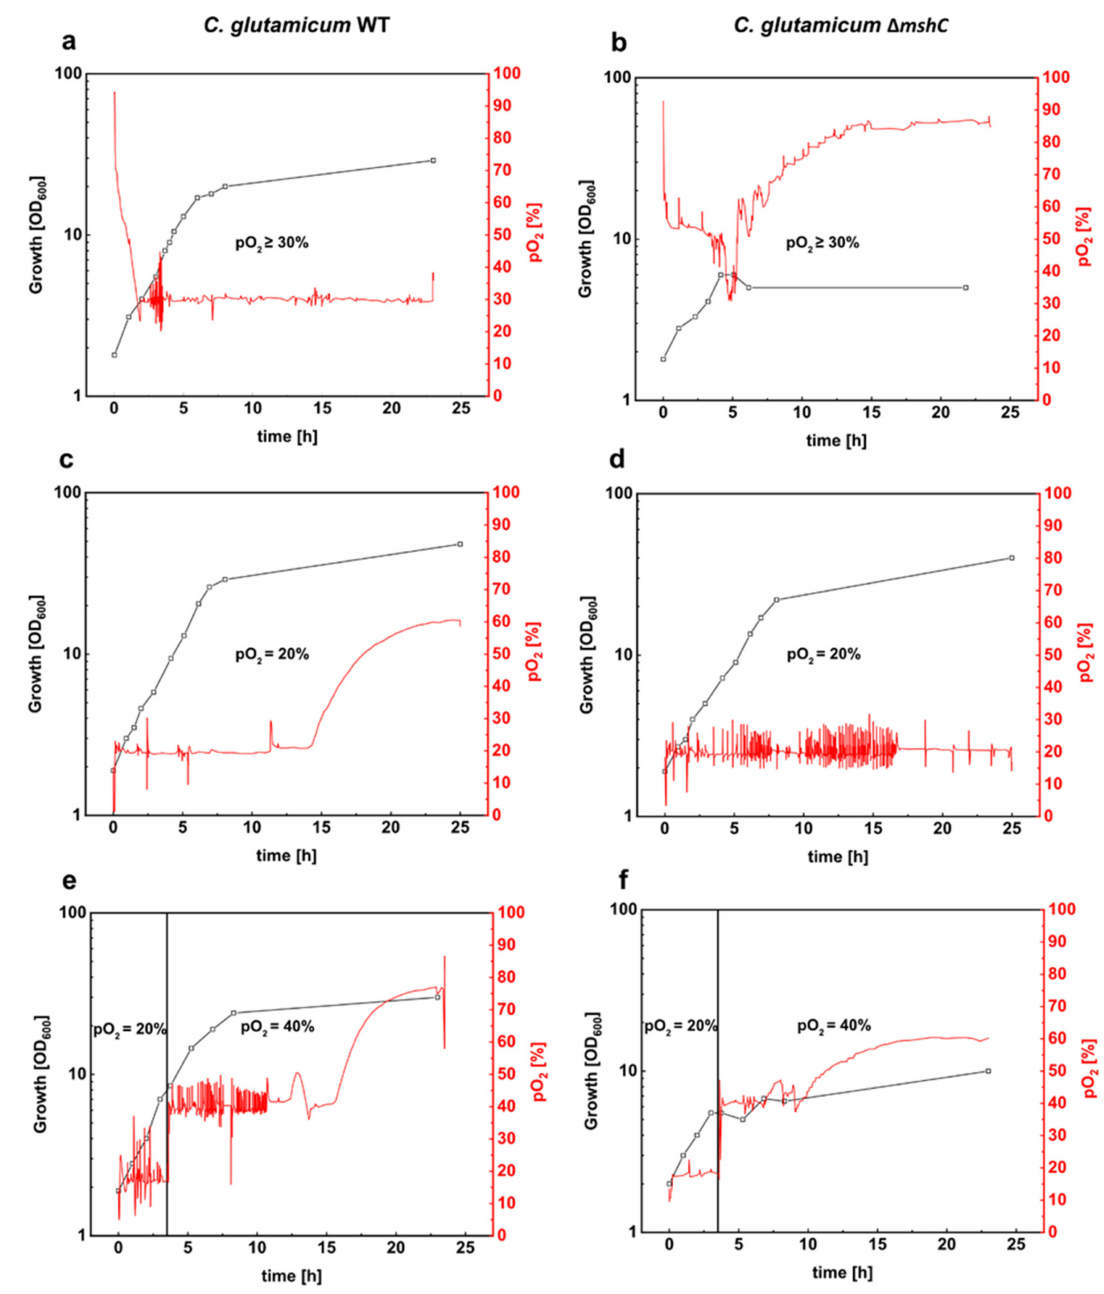
Figure 1. Batch cultivations of C. glutamicum WT (left plots) and the mycothiol-deficient C. glutamicum mutant ∆ mshC (right plots) in stirred bioreactors. Both strains were cultivated in 1 L CgXII minimal medium (T = 30 ◦ C, pH = 7.0; initial glucose concentration 20 g L − 1 ). Bioreactor experiments were performed by setting di ff erent pO 2 values. pO 2 values of ≥ 30% regulated via stirring (200 rpm–800 rpm) ( a , b ). pO 2 values of 20% were set by stirring as well as mixing nitrogen and air for the inlet gas ( c , d ). Finally, bioreactor experiments were carried out with an initial pO 2 value of 20% during the first 3 h and a second fermentation phase with a pO 2 value of 40% ( e , f ). Growth was monitored by measuring the optical density at 600 nm. Fermentations were performed in BIOSTAT ® B bioreactors. Data were collected with the software MFCS. OD, optical